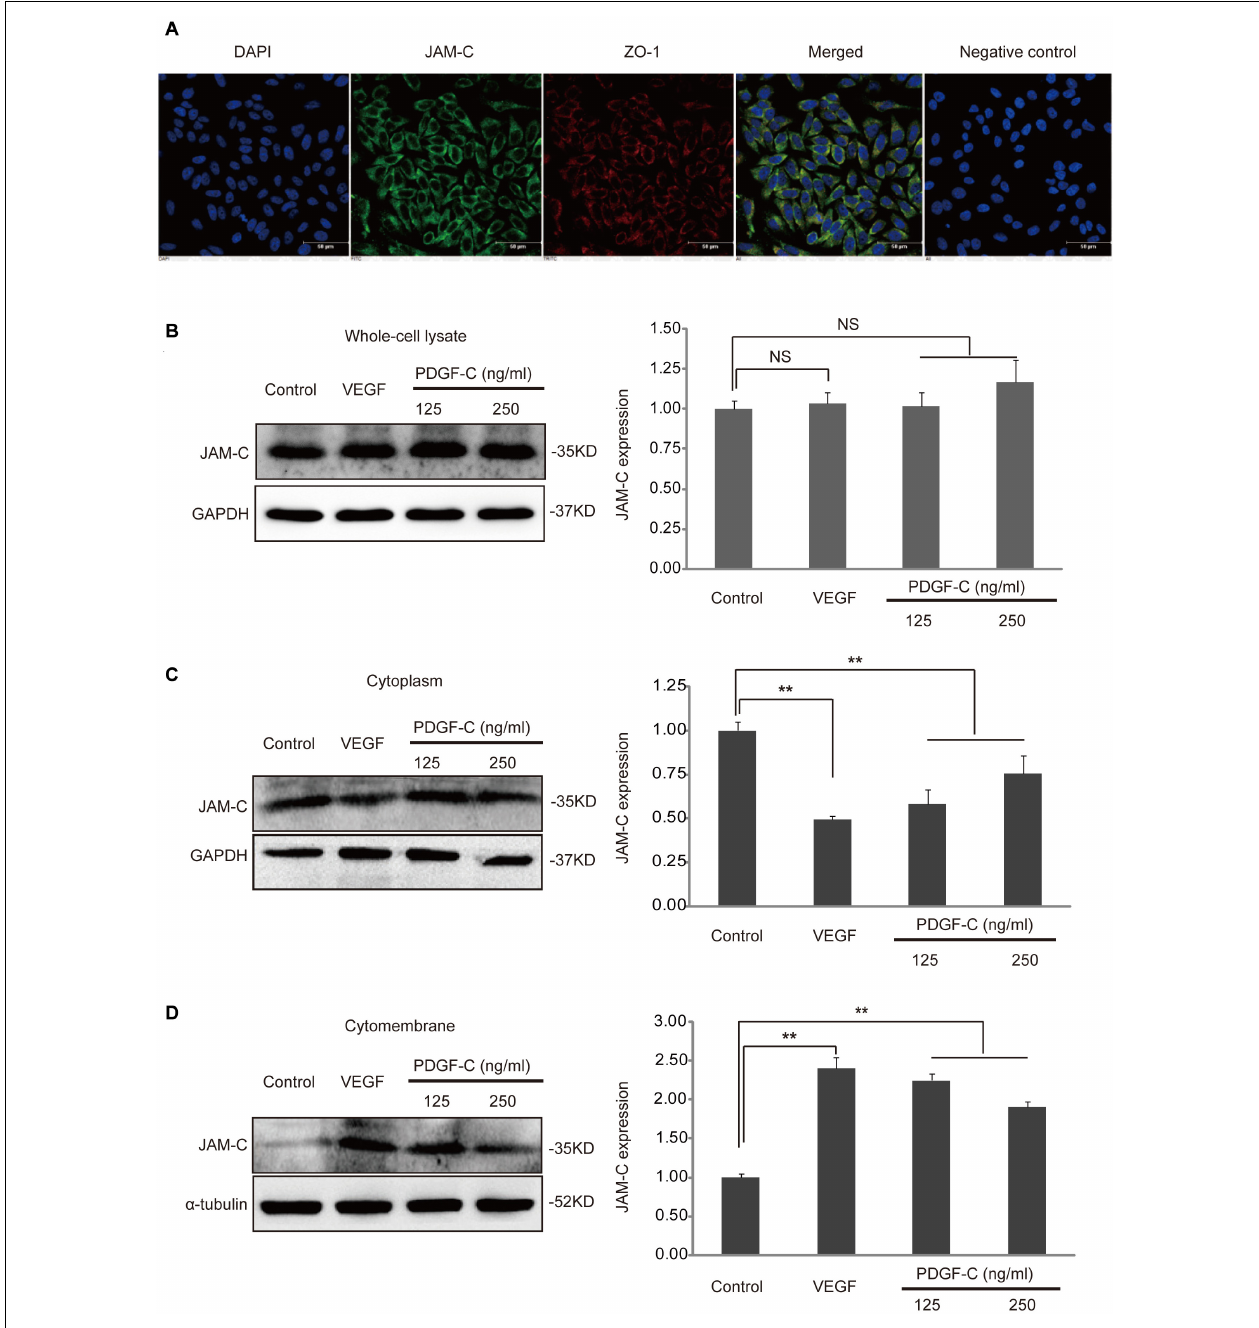
FIGURE 1 | JAM-C expression and translocation in human RCECs. (A) JAM-C expression in cultured human RCECs is shown by immunofluorescence staining (blue: DAPI, green: JAM-C, red: ZO-1, scale bar: 50 µ m). JAM-C co-localized with ZO-1 in RCECs. A negative control staining without the primary antibody against JAM-C or ZO-1 showed no staining. (B) Cultured human RCECs were treated with VEGF (10 ng/mL) or PDGF-C (125, 250 ng/mL) for 1 h. JAM-C protein in the whole-cell lysate was similar as shown by Western blot. (C) In the cytoplasmic fraction, JAM-C protein levels decreased after VEGF or PDGF-C protein treatment. (D) In the cytomembrane fraction, JAM-C protein levels increased after VEGF or PDGF-C treatment. The dynamic changes in JAM-C translocation induced by PDGF-C were dose-dependent. ** P < 0.01, NS, not significant.